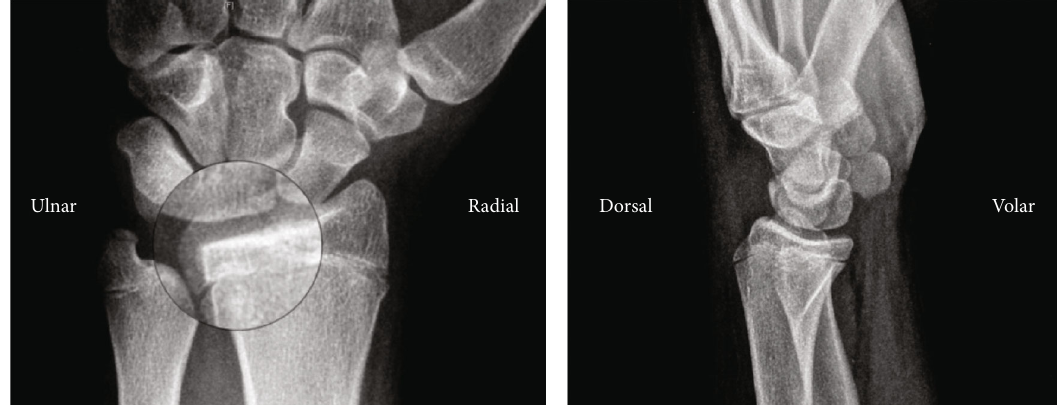
Figure 1: Plain PA and lateral radiographs of the left wrist demonstrating intra-articular fracture at dorsoulnar lip of the radius.